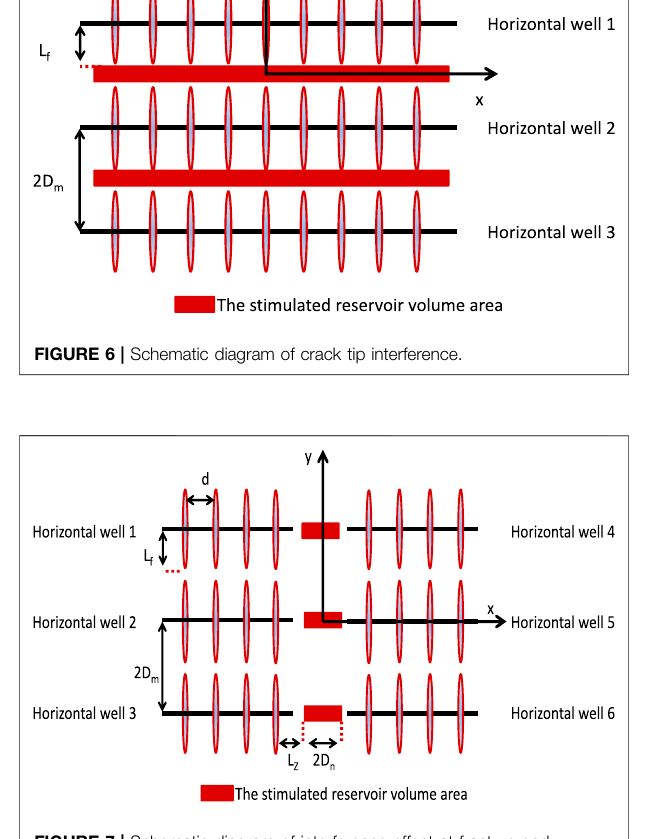
horizontal wells is 2 D n , and the end of each production well is regarded as a particle. The x -axis is established by the extension line of the horizontal section of well-2 and well-5, and the y -axis is established by the middle vertical line between the fracture ends.